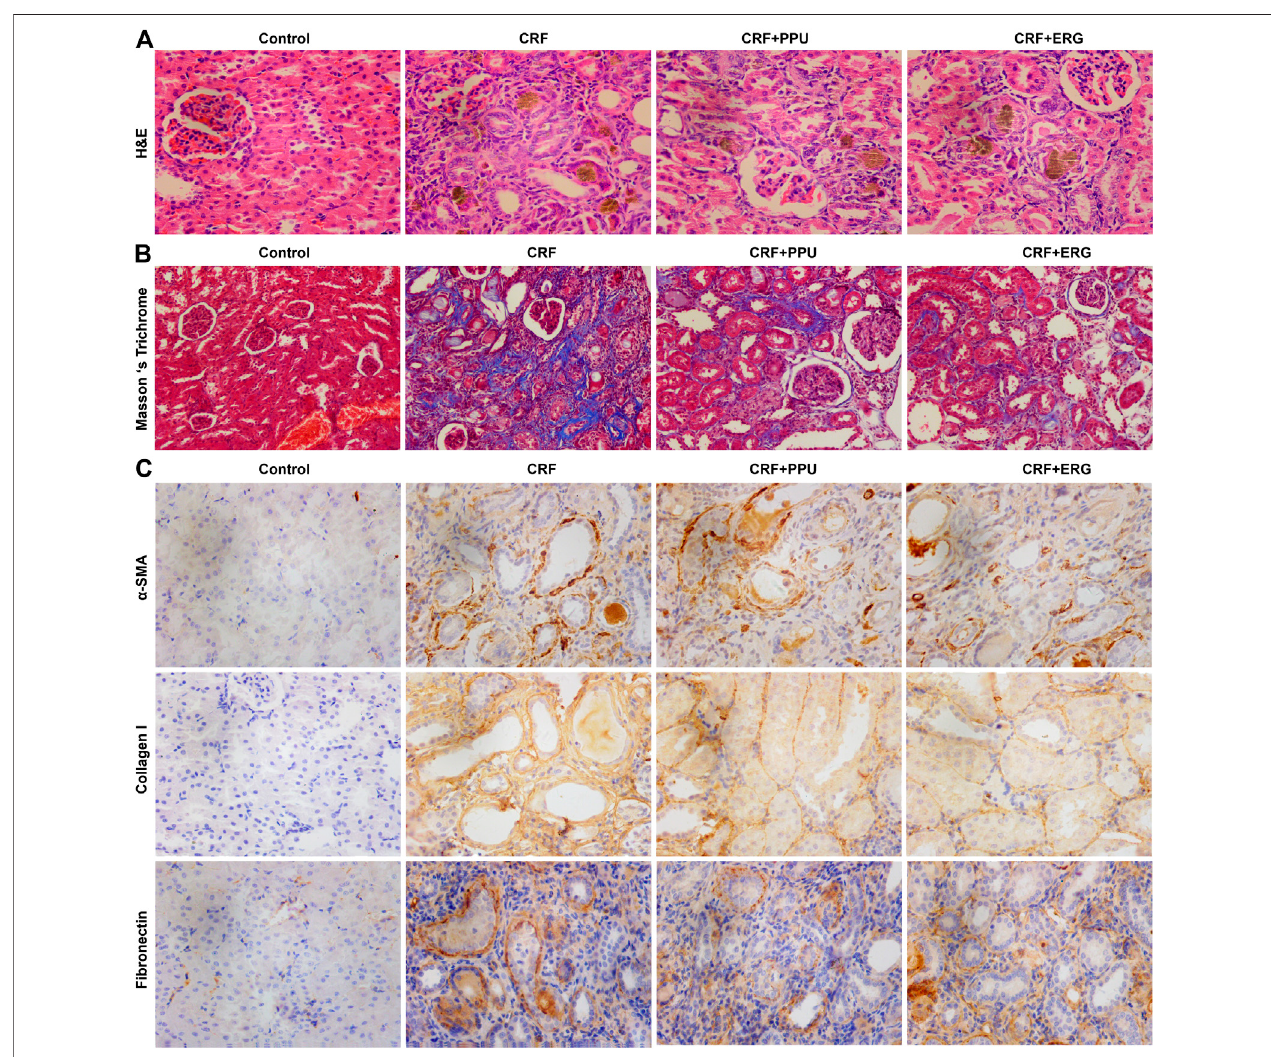
FIGURE 6 | Treatment with PPU and ergone ameliorate renal fi brosis. (A) Representative images of H&E stained kidney sections from control, adenine-induced CRF, CRF + PPU, and CRF + ERG groups. Magni fi cation, × 400. (B) Representative images of Masson ’ s trichrome stained kidney sections from control, adenine- inducedCRF,CRF+PPU,andCRF+ERGgroups.Magni fi cation, × 200. (C) Immunohistochemicalanalyseswithanti- α -SMA,collagenIand fi bronectinantibodiesofrat kidney tissues in the control, adenine-induced CRF, CRF + PPU, and CRF + ERG groups. Magni fi cation, × 400.